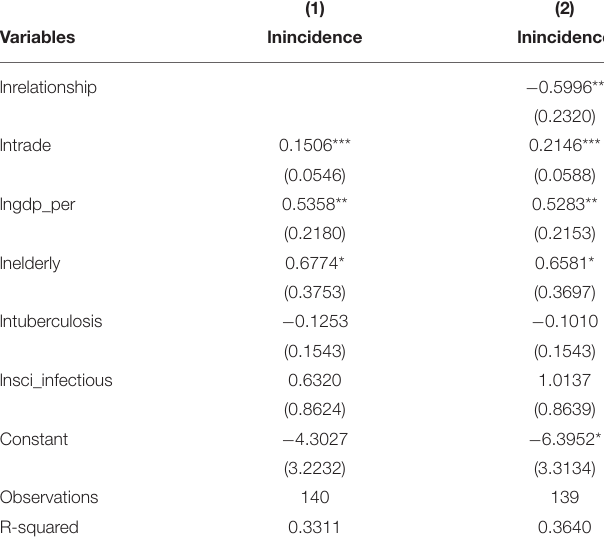
TABLE 3 | Baseline regression